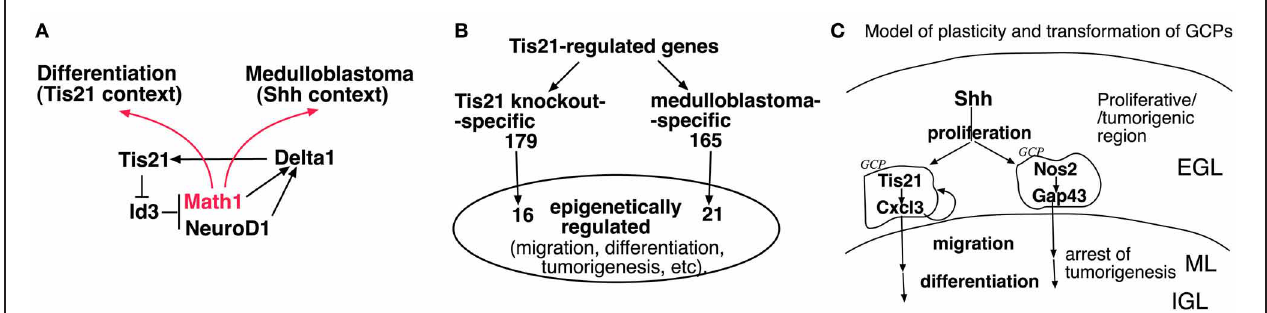
FIGURE 1 | Proposed models of plasticity and transformation of cerebellar granule precursor cells (GCPs) in response to Math1, Tis21, Nos2, Cxcl3, or Gap43. (A) Hypothetical model for the ambivalent role of Math1 (Atoh1) in tumorigenesis and differentiation; in a proliferative (Shh) environment Math1 favors tumorigenesis, while when GCPs are exposed to a differentiative signal (Tis21), Math1 may have a prodifferentiative action. Math1 and Id3 were not selected among the 344 genes whose expression is modified by Tis21-knockout in the report by Farioli-Vecchioli et al. (2012a), because of the stringent cut-off imposed on the statistical analysis. See